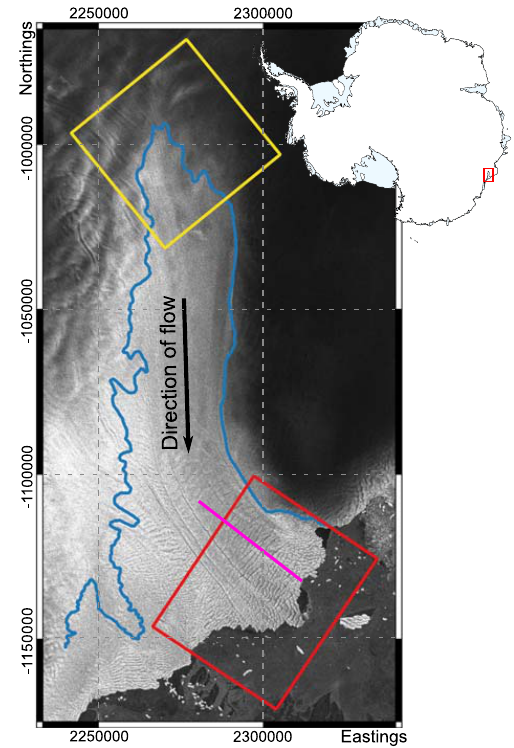
Figure 1. Locations of model domains. Blue line shows the ground- ing line as defined by the ASAID (Antarctic Surface Accumulation and Ice Discharge) project (Bindschadler et al., 2011a). Red box shows extent of HiDEM calving front model. Yellow box shows ex- tent of HiDEM grounding-line model. Pink line shows flight path used to tune the KPZ model. Background image: Sentinel 1, De- cember